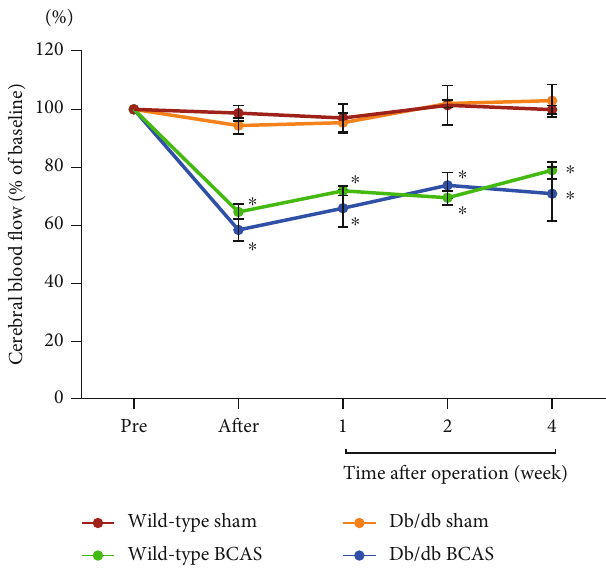
Figure 1: Cerebral blood fl ow (CBF) changes in di ff erent groups of mice. CBF was measured at the following time points: preoperation, right after the operation, one, two, and four weeks after the operation. CBF value was expressed as the percentage of baseline CBF value for each animal. Data were presented as the mean ± SEM . Pre: pre-BCAS/sham operation; after: right after BCAS/sham operation. N = 5 , ∗ p < 0 : 05 compared with